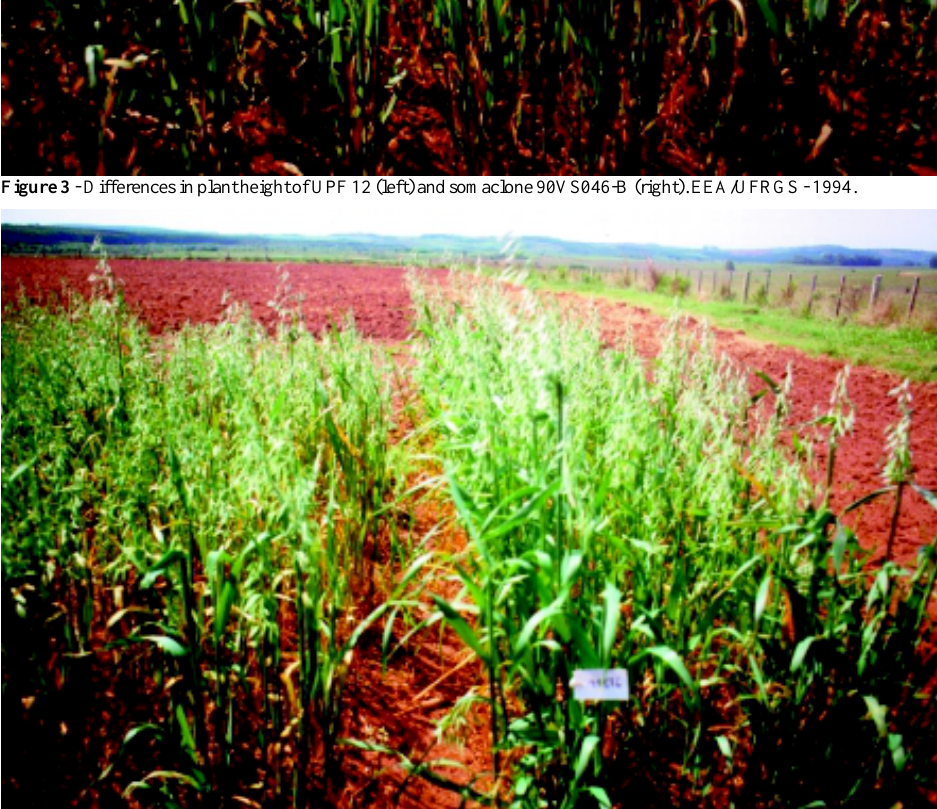
Figure 4 - Differences in plant height of UFRGS 7 (left) and somaclone 91VS109 (right). EEA/UFRGS -